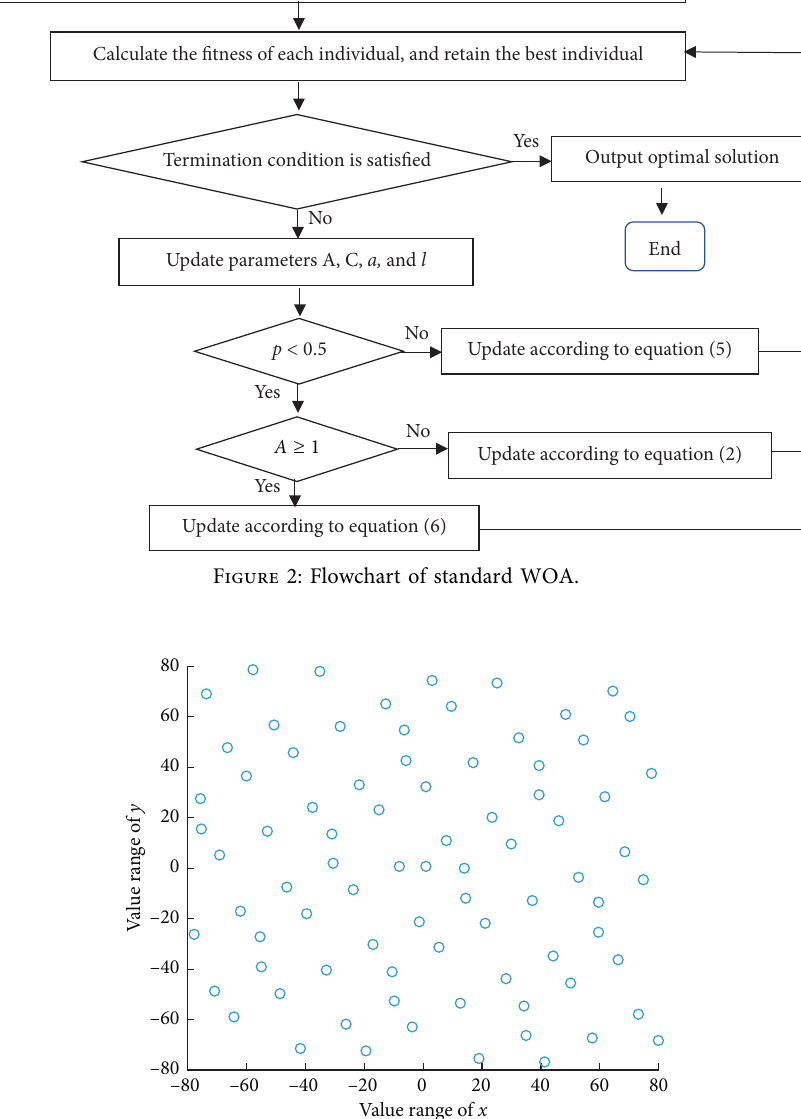
Figure 3: Initial solution generated by good point set.